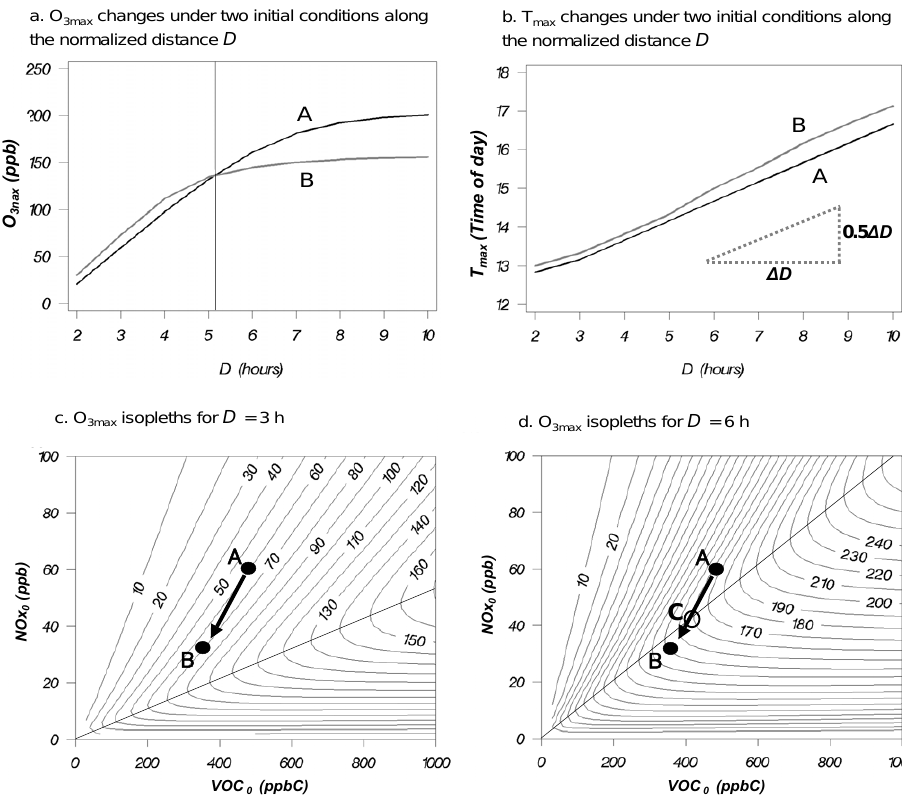
Fig. 8. (a) Examples of O 3max changes with downwind distance from sources A (NO x0 =60ppb, VOC 0 =480ppbC) and B (NO x0 reduced by 45% and VOC 0 reduced by 22.5% from A) under 95–100th percentile rank TMA ozone meteorological conditions. Source length L is set to 2h. (b) T max (occurrence time of O 3max ) changes with distance from sources A and B. (c, d) Isopleth diagrams of O 3max (ppb) for the normalized distance D =3 or 6h. Points A and B indicate the initial concentrations for panel (a) and (b). Point C is a crossing point with a regime boundary line.